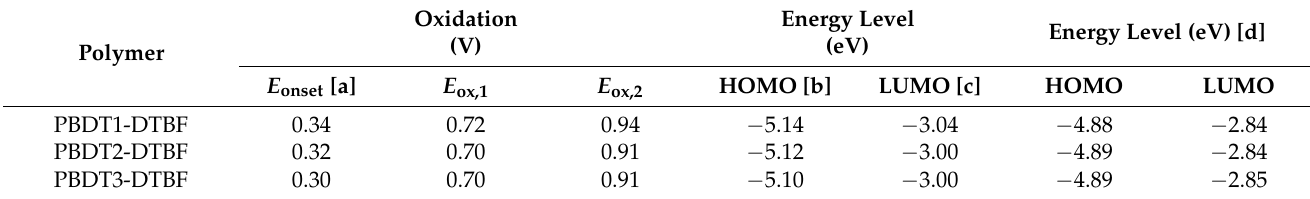
Table 4. Energy levels of polymers for the PBDT1-DTBF, PBDT2-DTBF and PBDT3-DTBF.